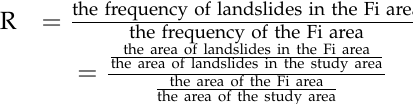
Figure 12. Frequency ratio (FR) for different joint and intersection sets in each mode of kinematic failure: ( a ) planar: the higher FR of joint 2 represents its dominance in creating planar failures; ( b ) topple: joint 1 is responsible for maximum flexural topple failures; ( c ) wedge: failure along joints 1 and 3 intersection is dominant for the slopes with susceptibility less than 80 and failures along joints 2 and 3 intersection are dominant for slopes with susceptibility more than 80; ( d ) FR comparison for failures due to different modes of failure suggests that wedge failure is the dominant type of failure followed by planar and topple.